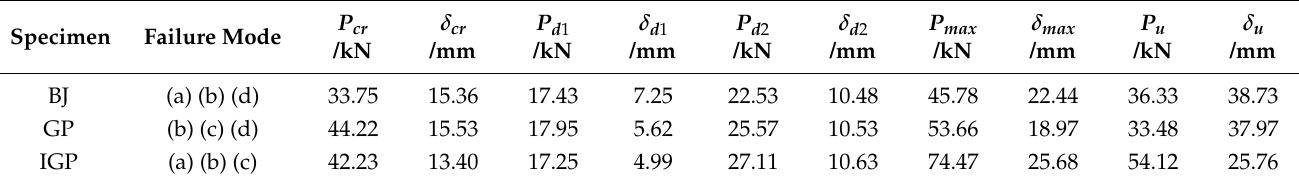
Table 3. Summary of static performance test results of GFRP pultruded truss